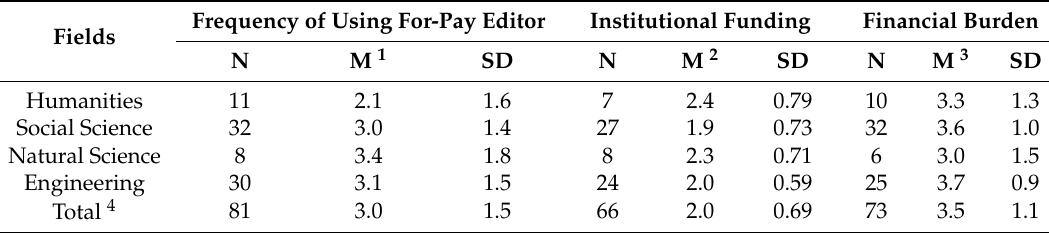
Table 1. Use of For-Pay Editing